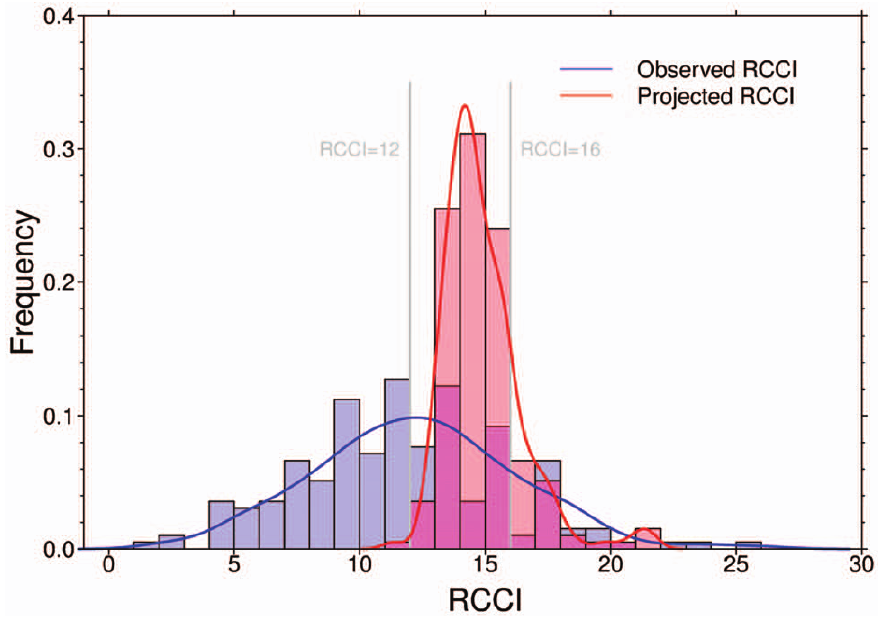
Figure 1. Frequency distributions of observed and projected Regional Climate Change Index (RCCI) across 196 G200 ecoregions. The observed RCCI (blue bars and solid line) is based on differences in climate conditions between 1961 2 1980 and 1991 2 2009, generated from Climate Research Unit (CRU) TS 3.1 datasets; the projected RCCI (red bars and solid line) is based on differences in climate conditions between 1991 2 2010 and 2081 2 2100, generated from the ensemble of 62 GCM 6 GHG emission scenario combinations. The grey vertical lines represent the 50 th and 80 th percentile of observed RCCI (i.e., RCCI=12 and RCCI=16), indicating moderate and pronounced climate change, respectively.